Question: What kind of plot is shown here?
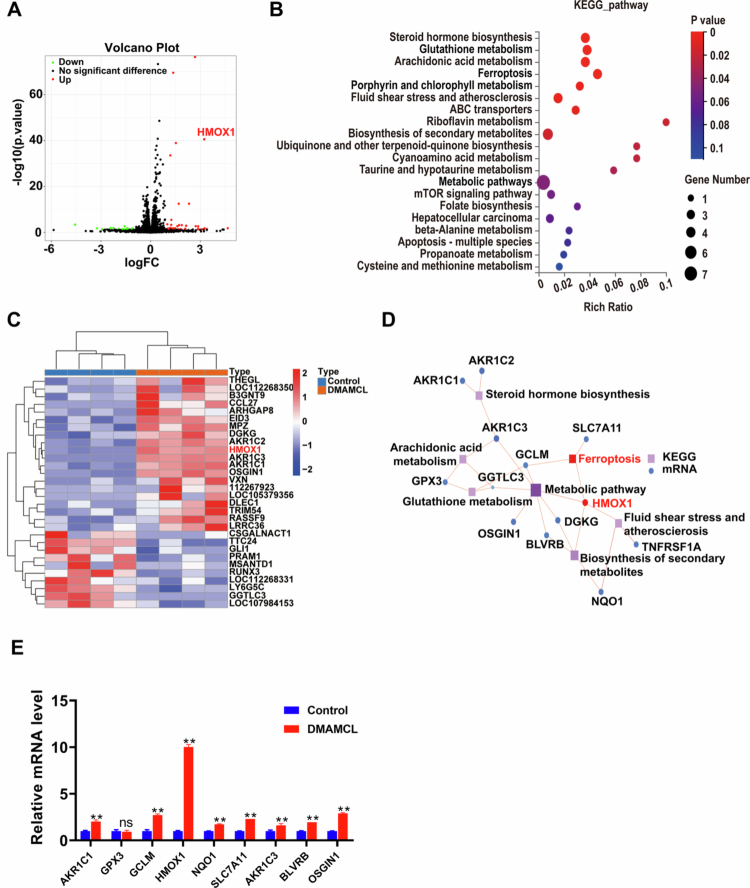
Answer: heatmap